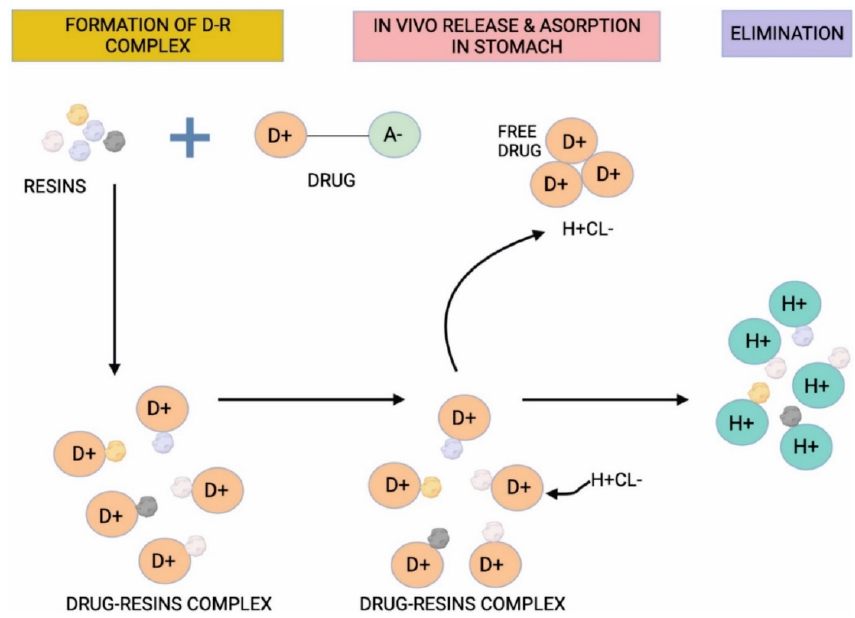
Figure 2. Formation and in vivo release mechanism of ion ‐ exchange resins.